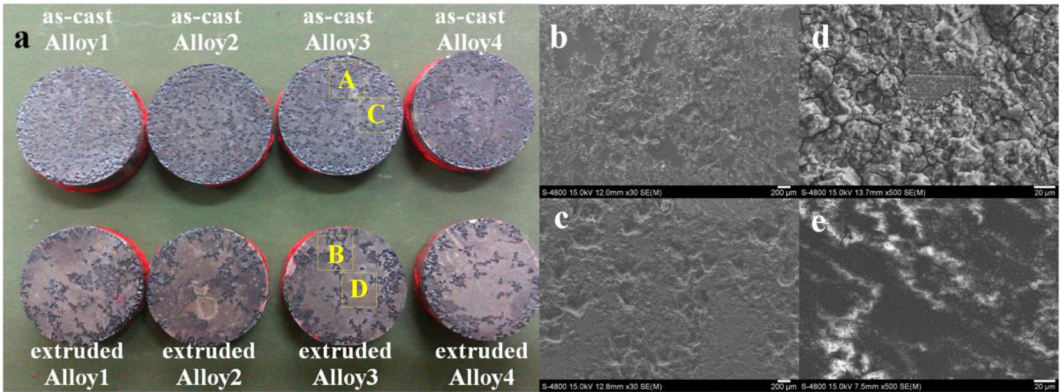
Figure 8. Macroscopic and SEM images of Mg (100 − 7x) Zn 6x Y x alloys after immersing in SBF for 24 h: ( a ) macroscopic photos; ( b – e ) magnified images of areas marked in ( a ), ( b – e ) represents areas A–D, respectively.